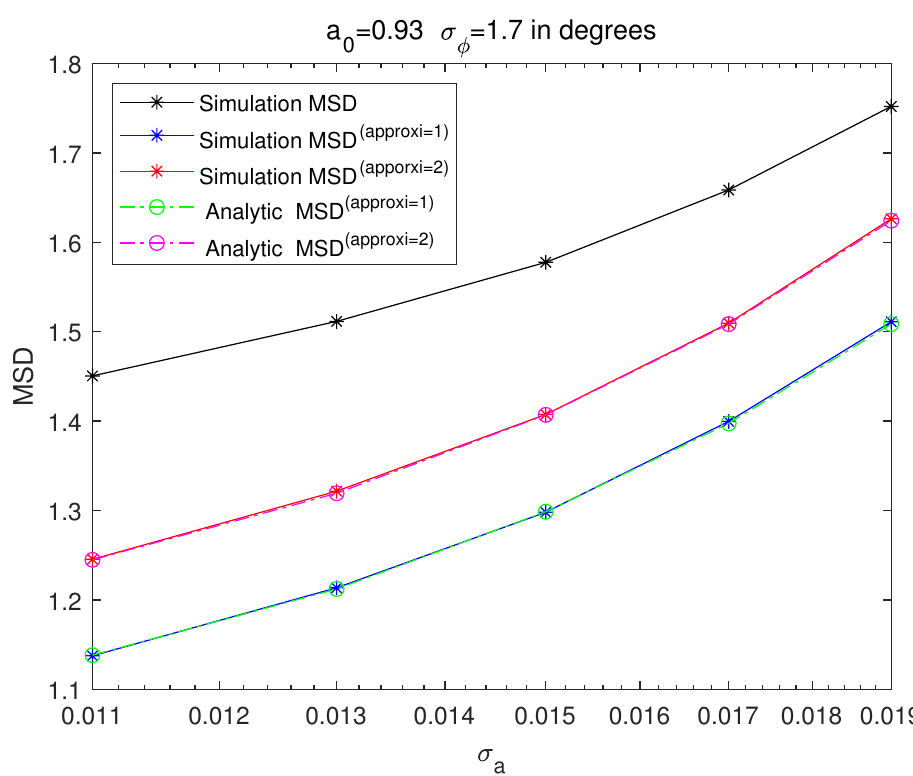
Figure 4. MSD of cross-eye gain, σ φ fixed to 1.7 ◦